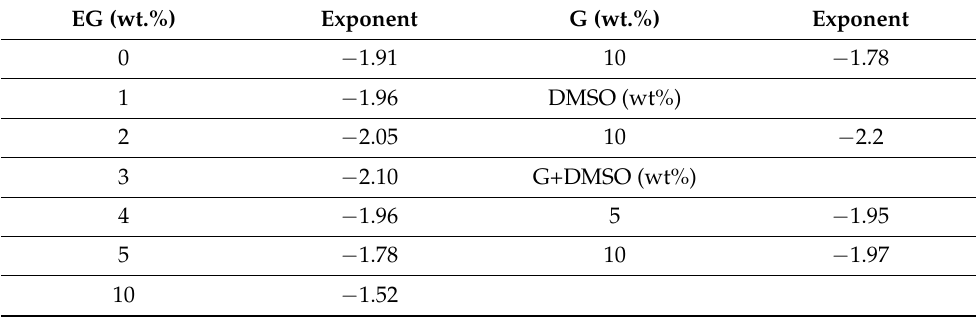
Table 2. Decay exponent for every SAXS intensity profile in the high- q range q = 0.7–1.1 nm − 1 . EG (wt.%)